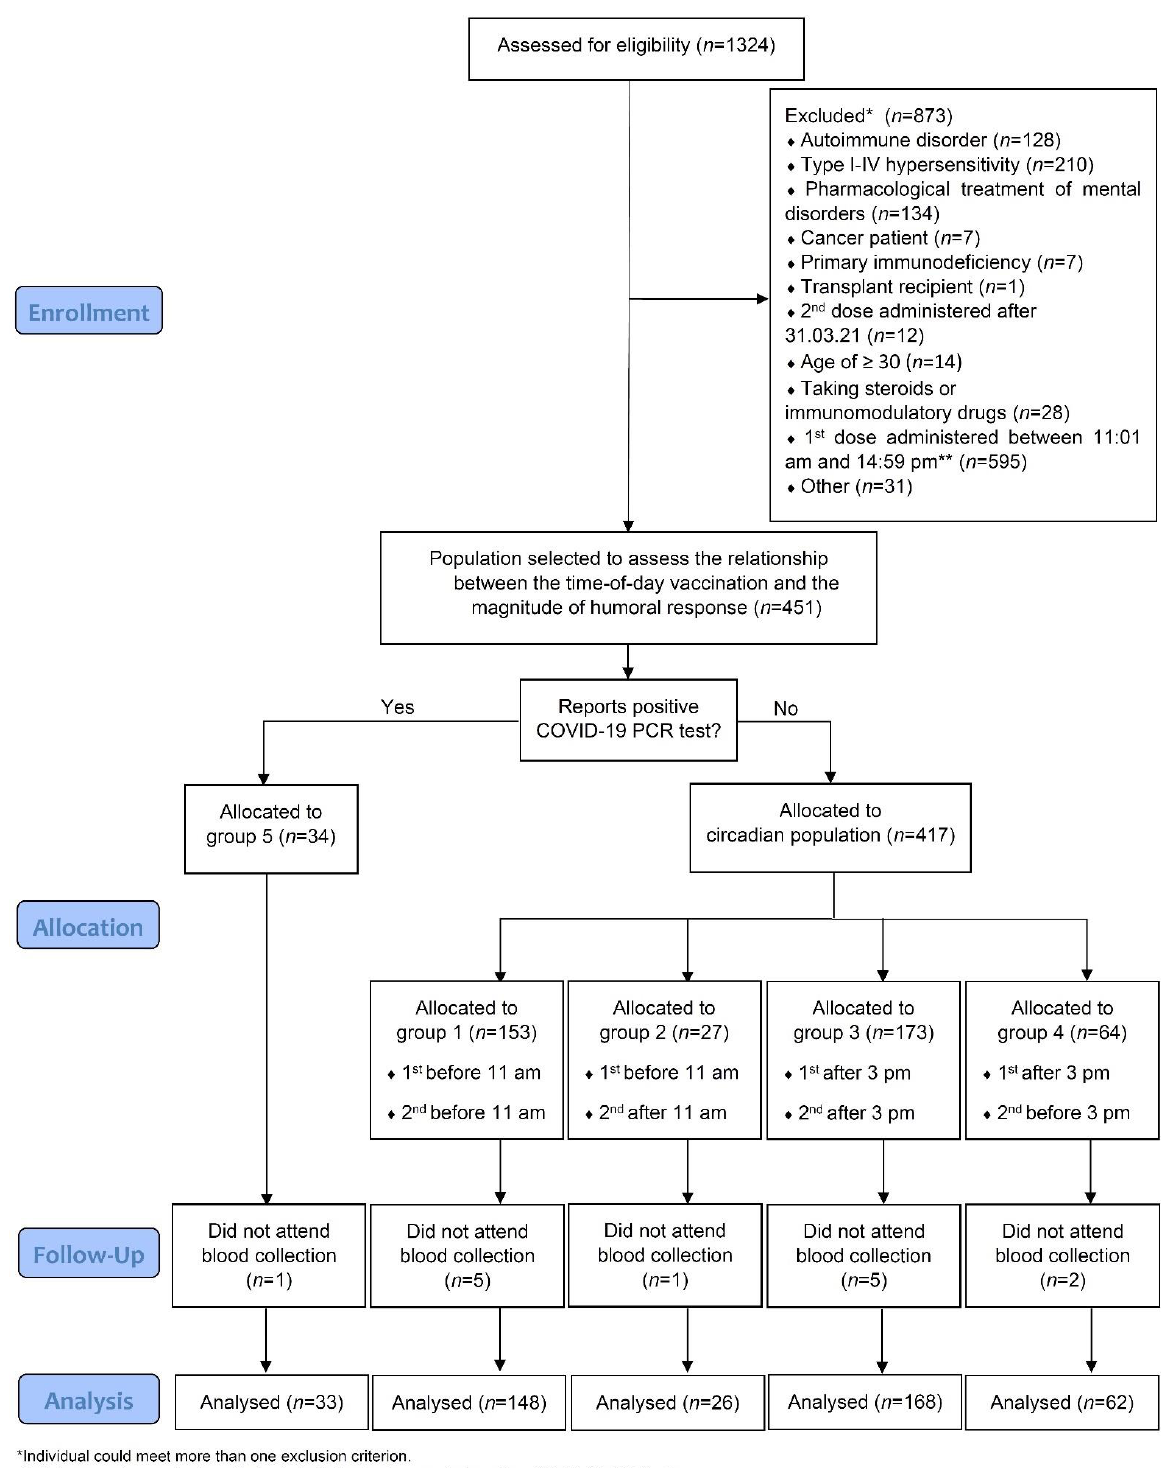
Figure 1. CONSORT diagram of participant enrollment and retention throughout the study.